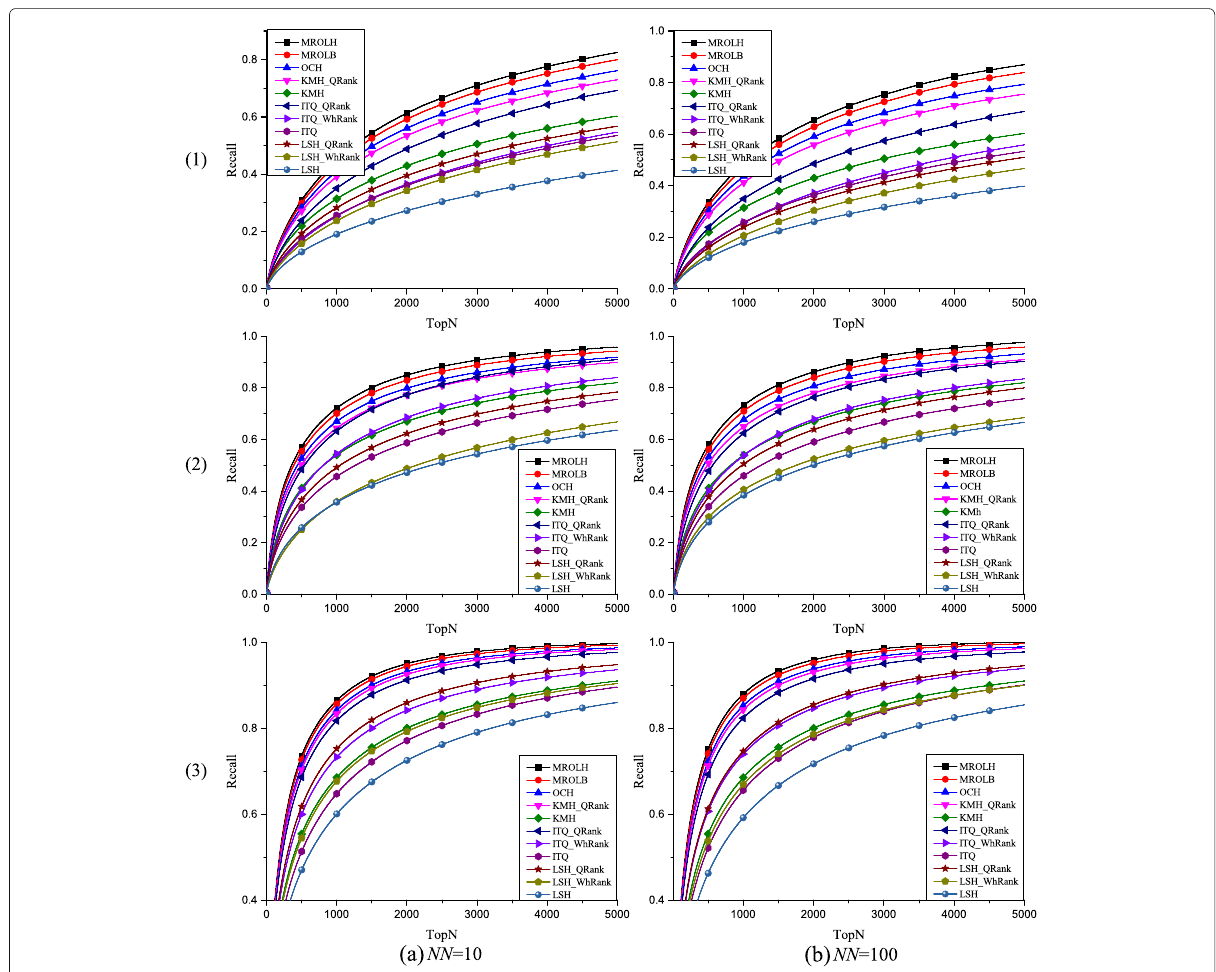
Fig. 5 The recall curves of the comparative experiments in the SIFT1M dataset. The data are separately mapped into 32-, 64-, and 128- bit binary codes in the (1), (2), and (3) rows. The number of the true nearest neighbors in columns a and b separately are 10 and 100